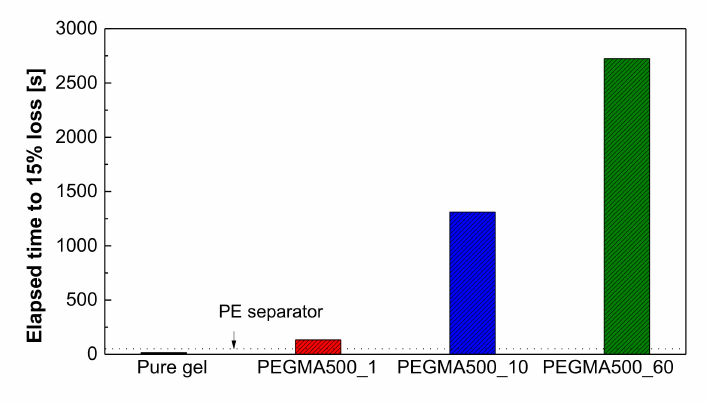
Figure 6. Durability analysis result according to the physical acceleration.